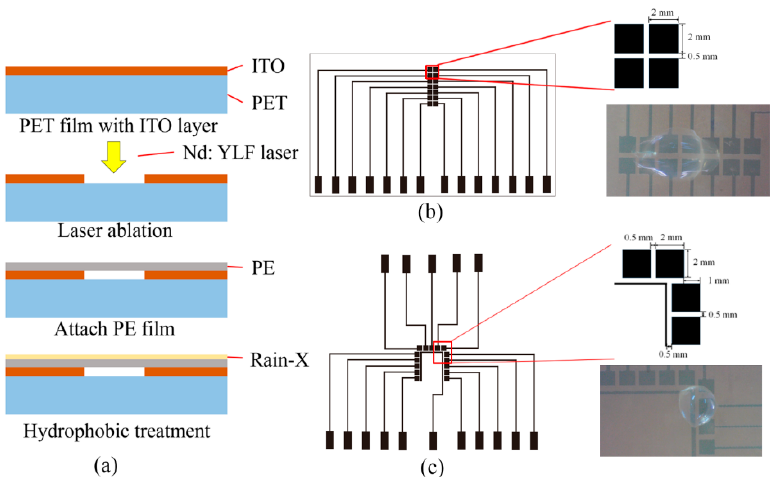
Figure 1. The design and fabrication process of the proposed digital microfluidic devices. ( a ): The fabrication process of the digital microfluidic device, a pulsed Nd: YAG laser was used to pattern the ITO layer on PET substrate to form electrodes array, then the ITO layer was insulated with a layer of PE film, finally, Rain-X water repellent was applied on the surface of PE film to enhance the hydrophobicity. ( b ): The digital microfluidic device for droplets merging. ( c ): The digital microfluidic device for droplets moving straight and turns. Video footages for the two proposed digital microfluidic devices are provided in the Supplementary Files.